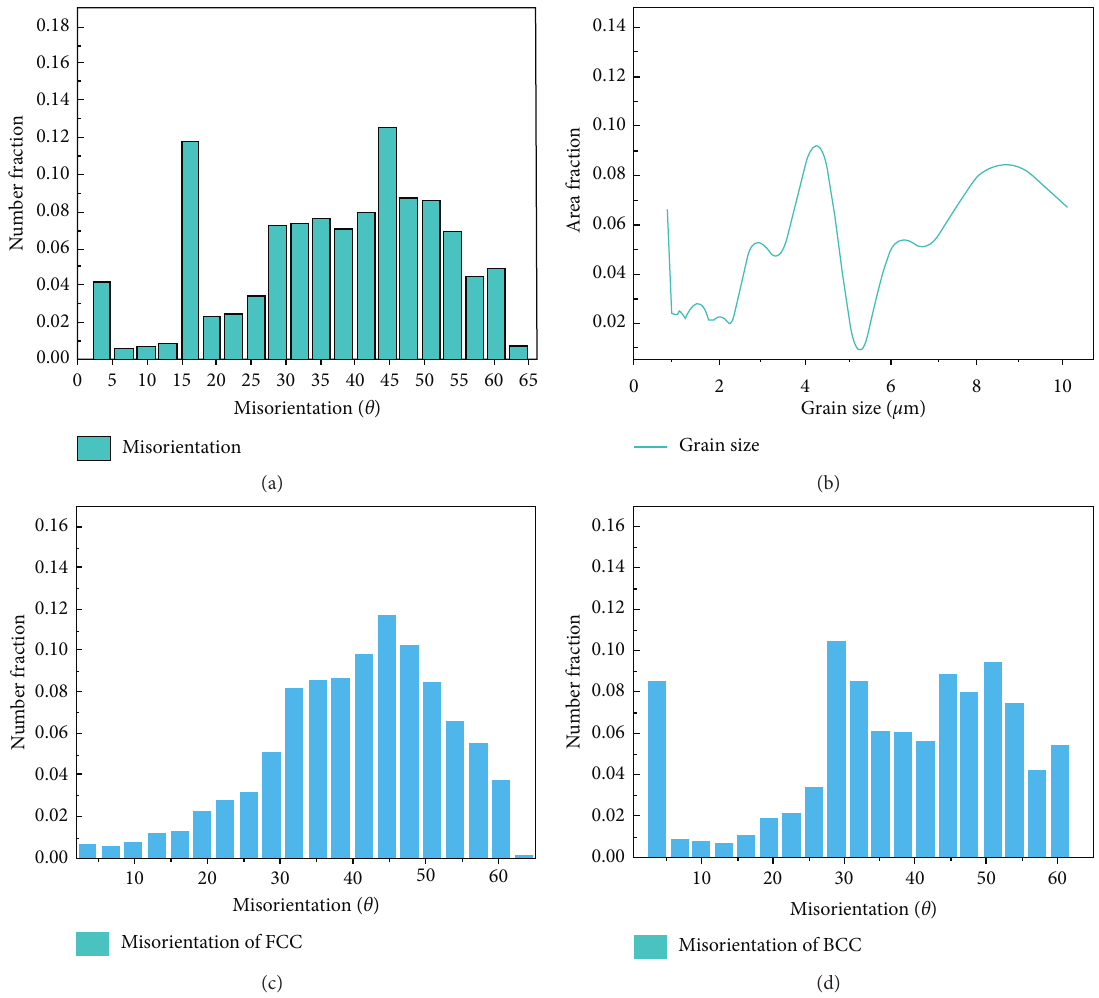
Figure 8: DCT at − 110 ° C and tempering at 350 ° C. (a) Misorientation histogram of grain, (b) image of grain size, (c) misorientation histogram of FCC, and (d) misorientation histogram of